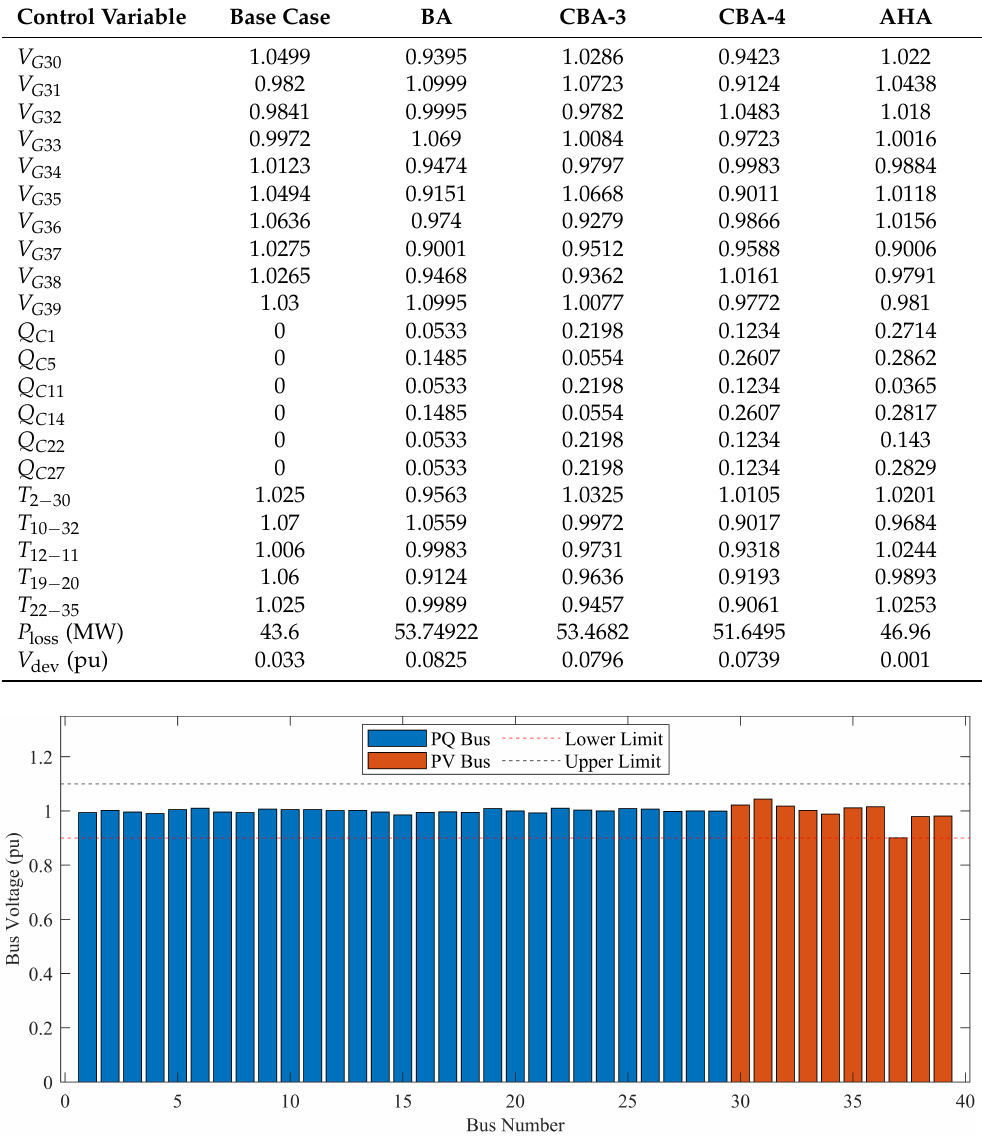
Table 8. Optimal values of control variables with V dev as an objective function for the IEEE 39 bus test system.